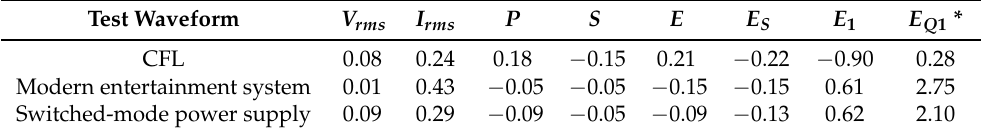
Table A5. CFL test